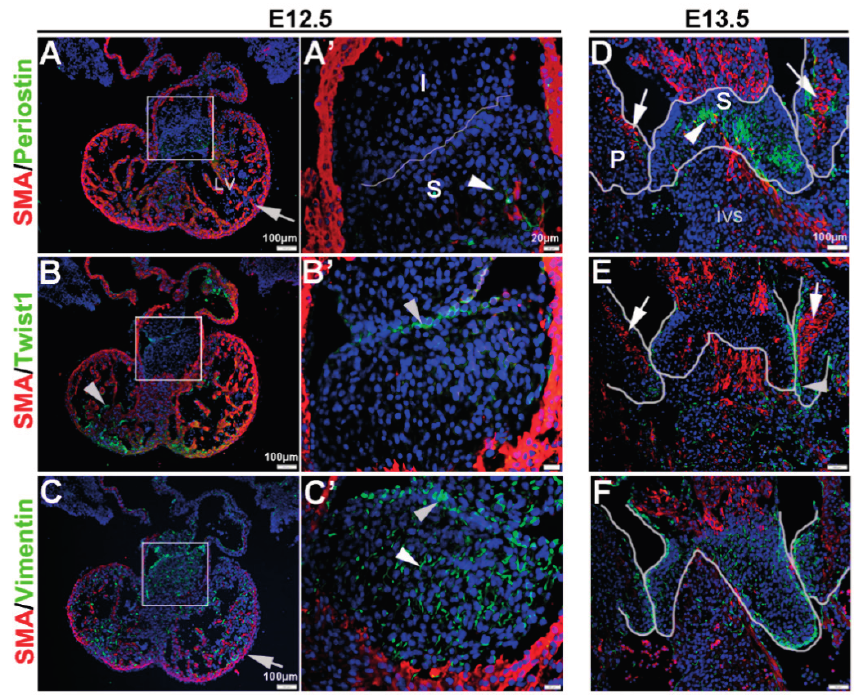
Figure 1. Characterization of VIC phenotypes during early heart valve